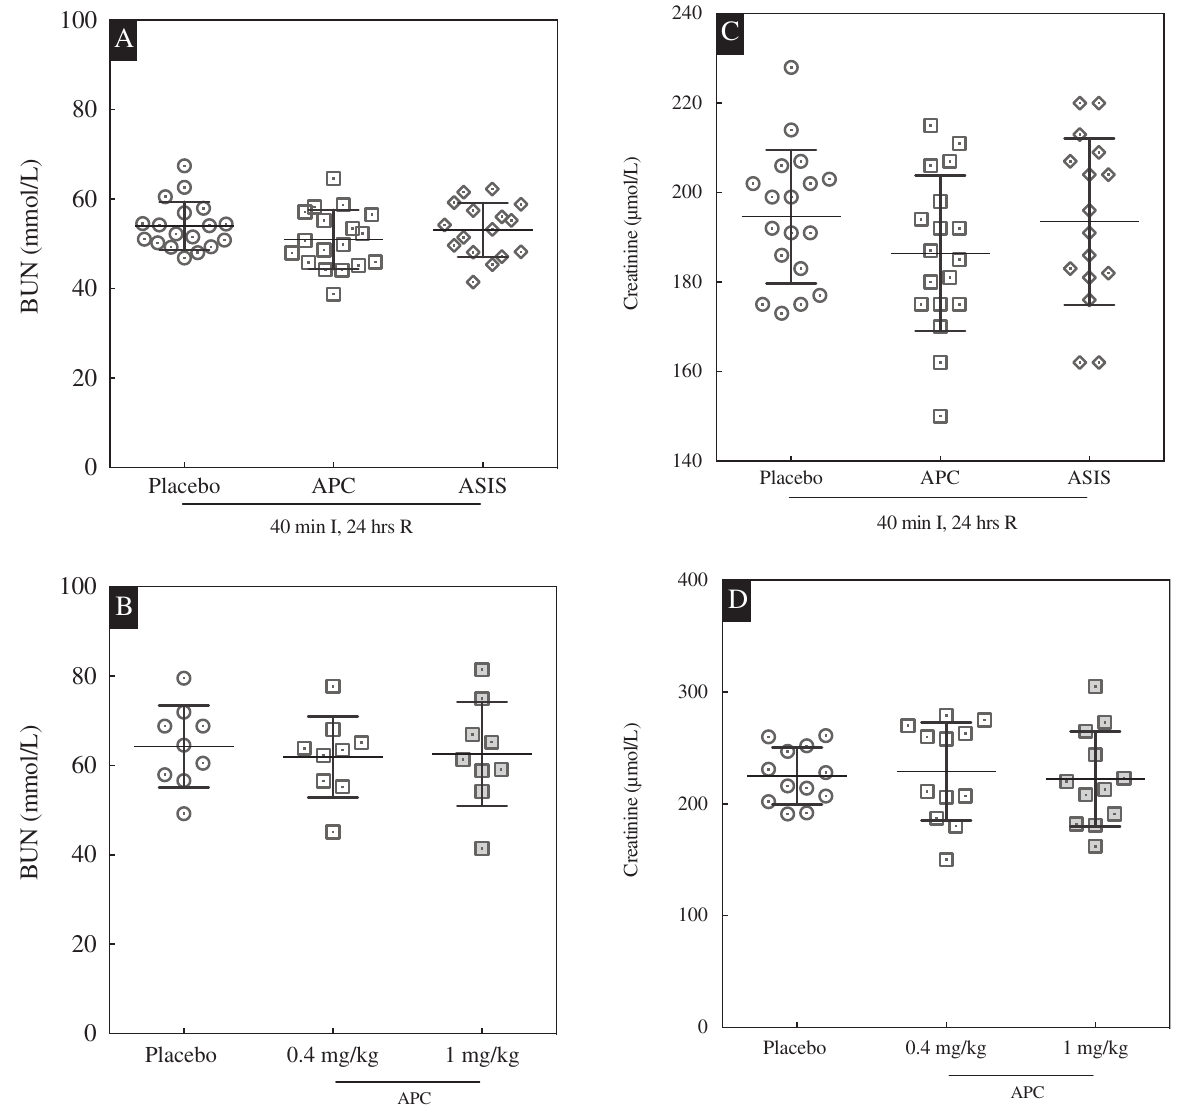
Figure 1. Panel A: BUN levels and Panel B: creatinine levels did not differ upon APC nor upon ASIS administration 2 min before induc- tion of reperfusion and 15 min after induction of reperfusion compared to placebo after 40 min of ischemia followed by 24 hr of reper- fusion. Administration of APC in a higher dose and at an earlier time point in the ischemic phase did not reveal changes in Panel C: BUN or Panel D: creatinine levels compared to placebo. Values are mean ± SEM, n = 18 per